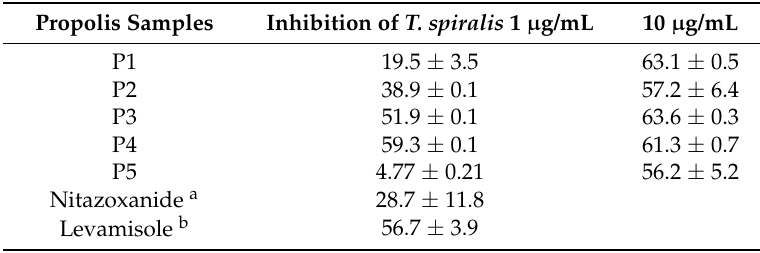
Table 2. Anthelminthic activity of crude propolis extracts P1–P5 against T. spiralis ( n =